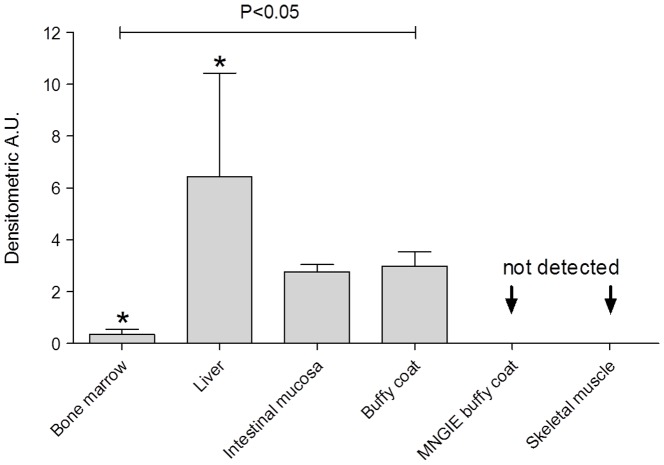
TP concentration and distribution in a panel of selected human tissues.The graph reports the A.U. calculated normalizing TP chemioluminescent signal on total proteins. Data are reported as mean ± SD using bone marrow as calibrator tissue. The TP concentrations vary significantly among different tissues (P< 0.05 one way ANOVA non-parametric test; *P< 0.05 Tukey's post-test).